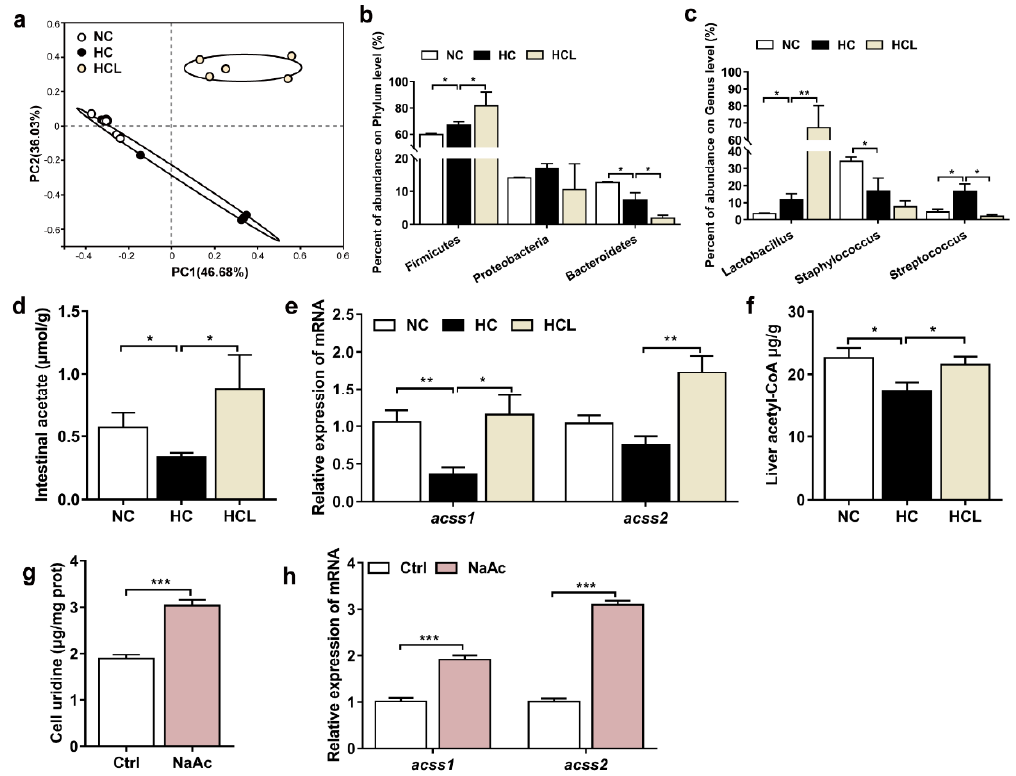
Figure 6. L. plantarum MR1 altered the gut microbiota composition. L. plantarum MR1-produced acetate promoted the uridine synthesis of Nile tilapia. ( a ) Principal coordinate analysis (PCoA) of the intestinal bacterial community. ( b ) Abundance of the gut bacteria at the phylum levels. ( c ) Abundance of the gut bacteria at the Genus levels. ( a - c ) n = 6 in NC and HC groups and n = 5 in HCL group. ( d ) Intestinal short-chain fatty acids (SCFAs) detection in Nile tilapia ( n = 6). ( e ) Gene expression of acss1 and acss2 in the liver ( n = 6). ( f ) Detection of the concentration of acetyl-CoA in the liver by HPLC ( n = 6). ( g ) Analysis of uridine contents in the sodium acetate (NaAc)-treated hepatocytes ( n = 6). ( h ) Gene expression of acss1 and acss2 in the hepatocytes ( n = 6). Statistics were analyzed by one-way ANOVA with Tukey’s adjustment ( a – f ) or Student’s t -test ( g , h ), and presented as mean ± SEM (*, p < 0.05; **, p < 0.01; ***, p < 0.001).